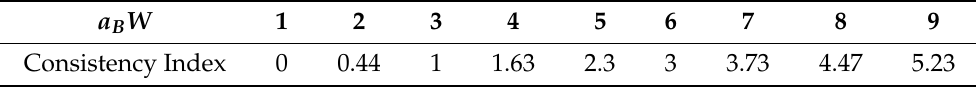
Table 1. Consistency index (CI)